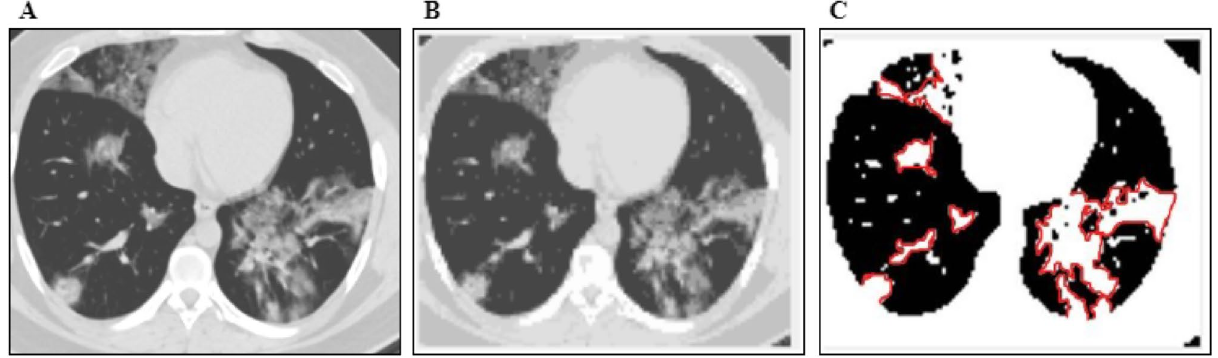
Figure 5. Image segmentation stages using region segmentation algorithm.